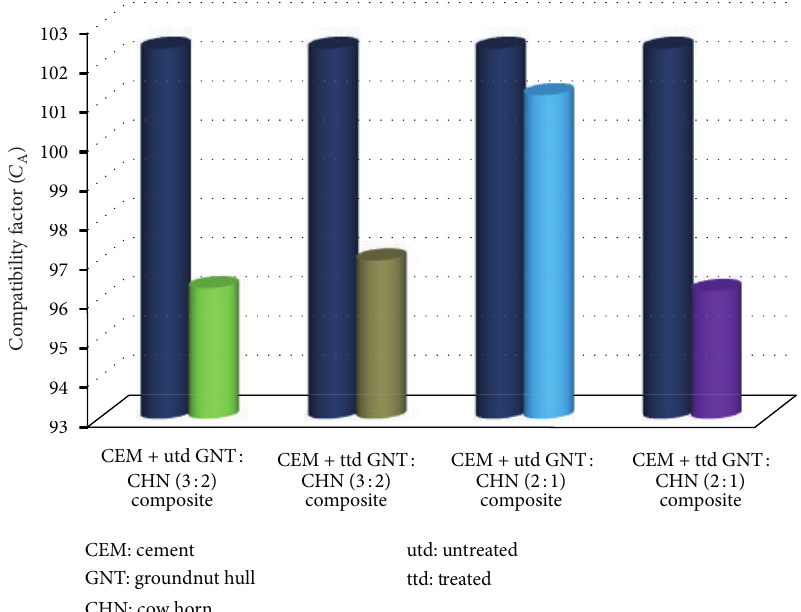
F 4: Effect of various ratios of cow horn particles and groundnut hull sample on the compatibility